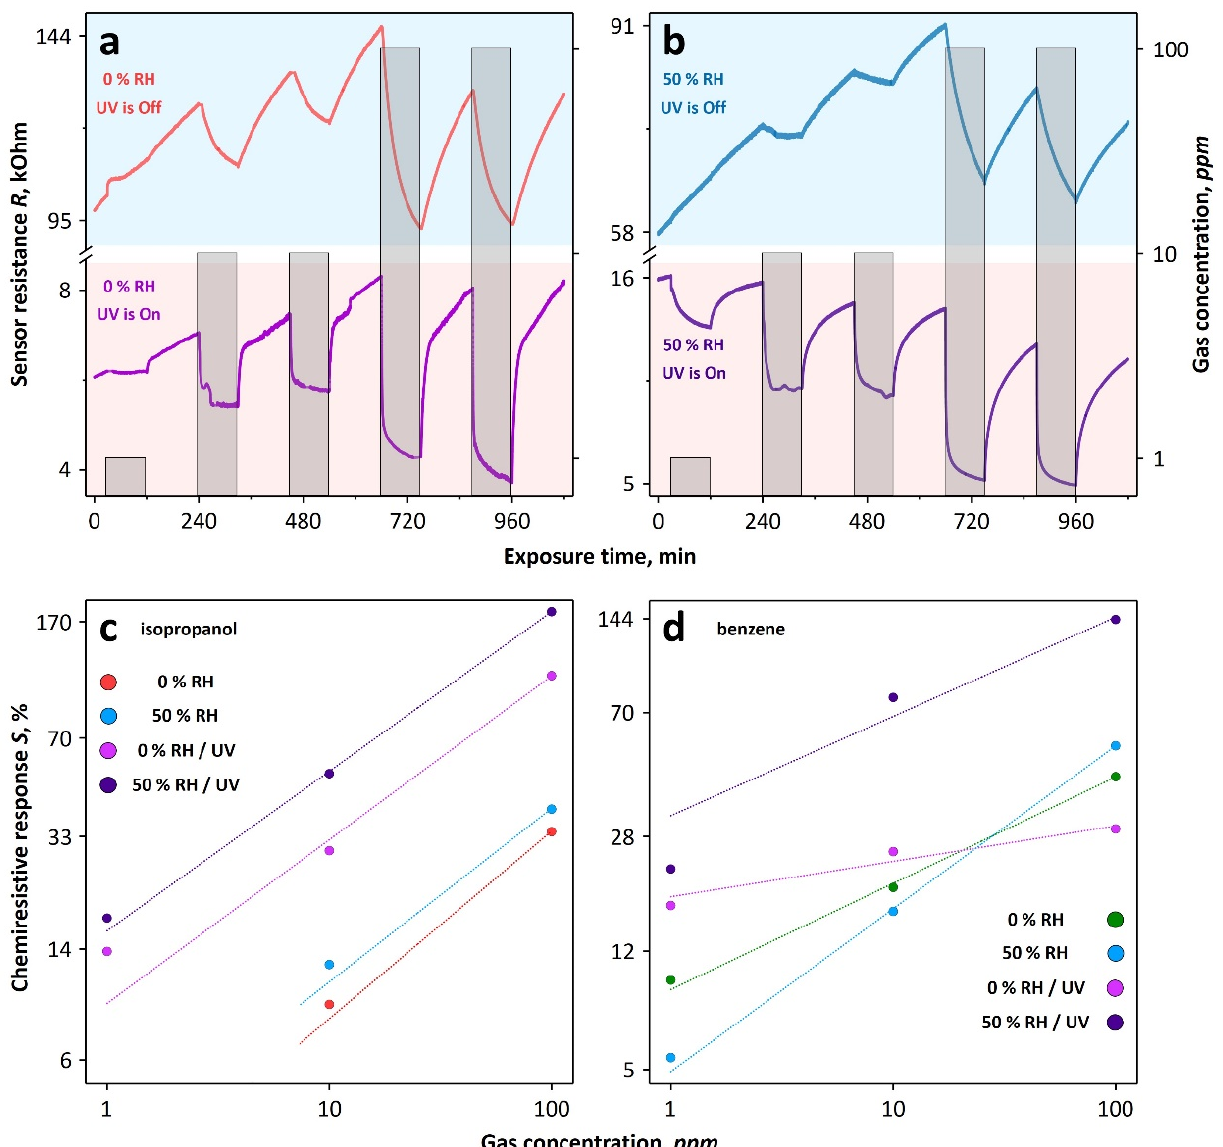
Figure 6. The gas-sensor performance of ZnO nanostructured layer upon exposing to VOCs of varied concentration under the operating temperature of 150 °C: ( a , b ) exemplary R(t) transients recorded versus isopropanol vapors, 1–100 ppm, in a mixture with dry air ( a ) and humid-enriched, 50 rel. %. air ( b ) when the LED-UV illumination is On and Off; ( c , d ) the dependence of chemiresistive response calculated according to (1) on the VOC concentration of isopropanol ( c ) and benzene ( d ). The data are shown for the layer grown electrochemically for 550 s.